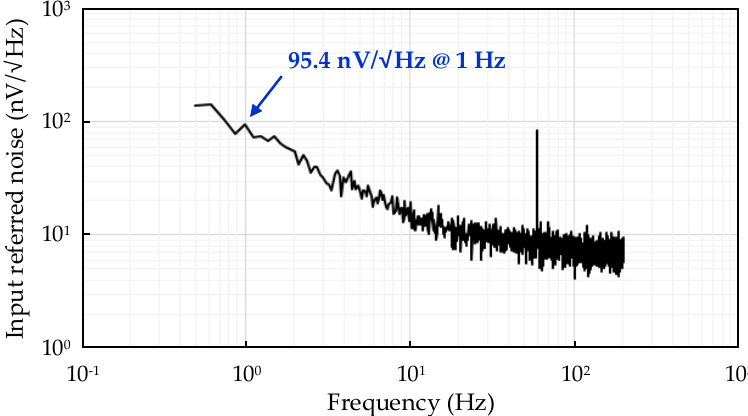
Figure 16. Input-referred noise measurement result of readout IC. The measurement environment and sensing robot settings for measuring the airflow velocity based on the time domain are shown in Figure 17. The sensing robot consists of a small printed circuit board (PCB) for the proposed readout IC and micro anemometer, a sensing laptop, four Vicons, and a transport robot. Four Vicons measurements were adopted in order to compare the data values of the proposed readout IC. The structure of the sensing robot is shown in Figure 17a. In this study, the air flow velocity was measured using the VVicons of the sensing robot moving in the directions of the x -axis and y -axis, and the data monitored in the monitoring laptop were compared with the data of the proposed readout IC. The measurement environment is shown in Figure 17b.